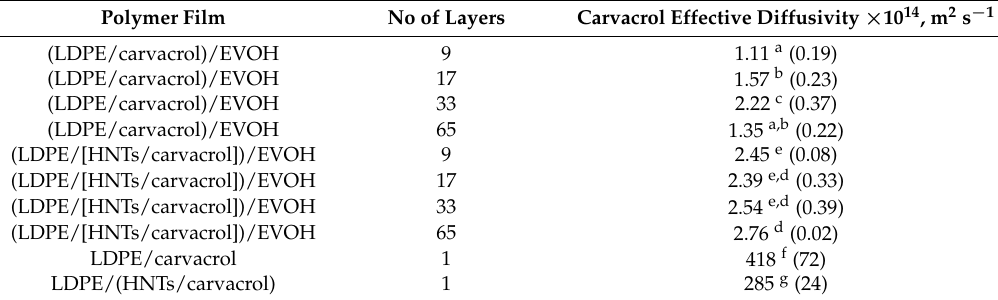
Table 3. Calculated effective diffusivity values for carvacrol from various films at 60 ◦ C. Determined by fitting the mathematical model for short times diffusion-limited desorption from a polymer film surface to the release profile of carvacrol from the films measured by TGA (the number in parenthesis indicate the standard deviation obtained from at least three independent